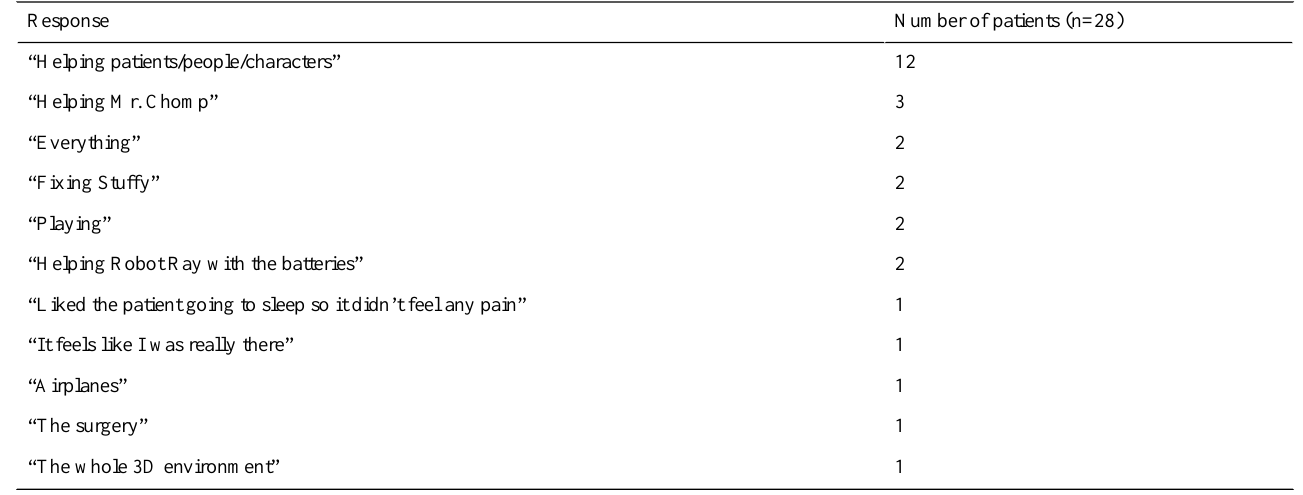
Table 3. Self-reported comments describing what the patients liked the most about the DocVR experience, in response to the question “What did you like MOST about ‘Doc McStuffins: Doctor for a Day?’”